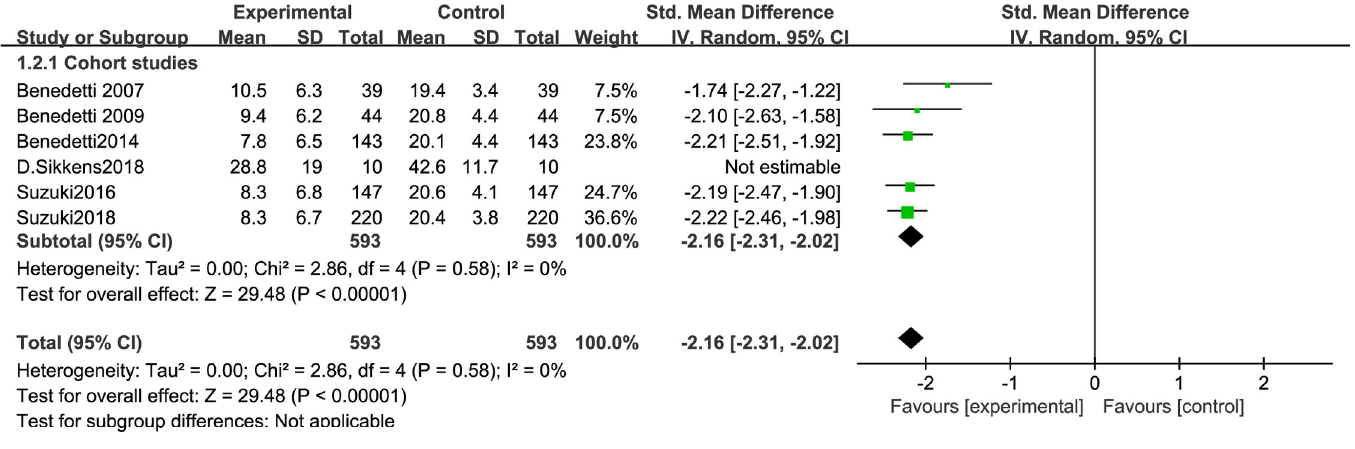
Fig 11. Forest plots with auxiliary